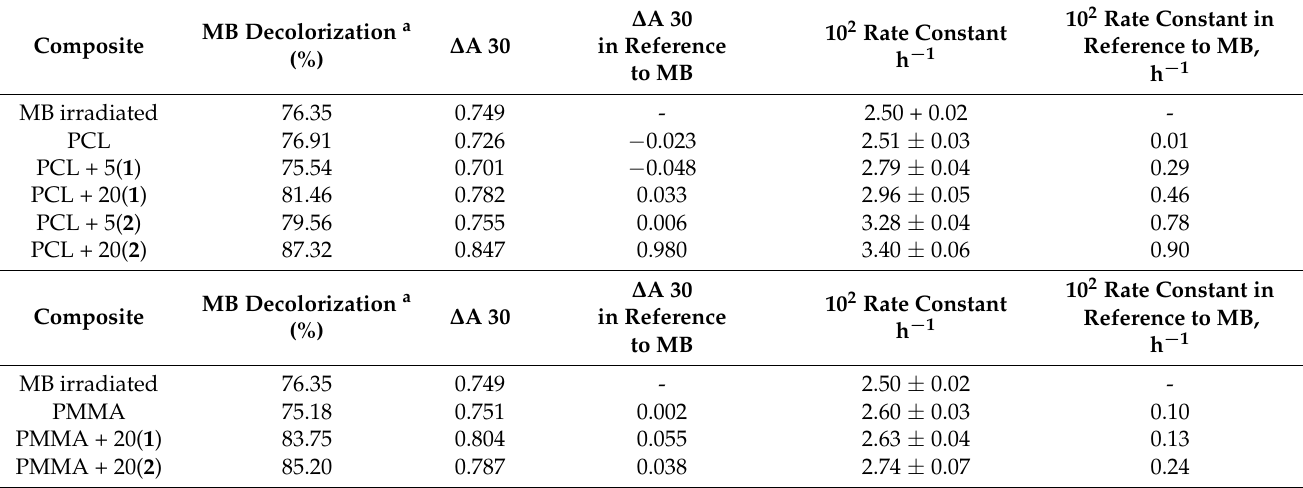
Table 4. MB solution decolorization percentages and ∆ A 180 parameters for the studied reactions in relation to the composites.